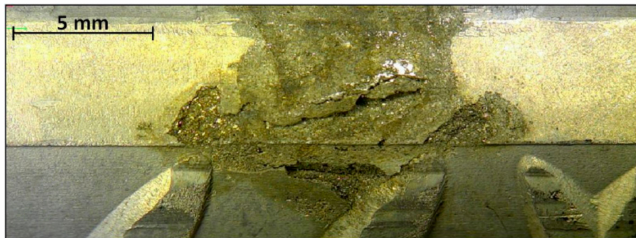
Figure 7. Optical image of the most severe corrosion damage found on a stainless steel reinforcement in concrete column C11 (located in the dry